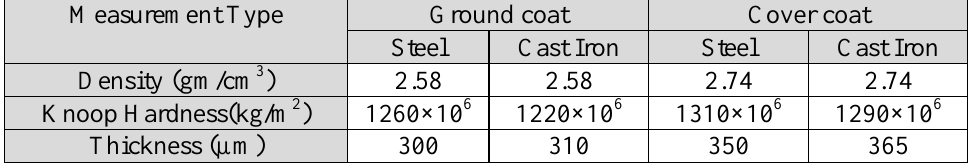
Table 7: Density, hardness and thickness of the coating enamel layer on the steel and cast iron with the addition of antimony